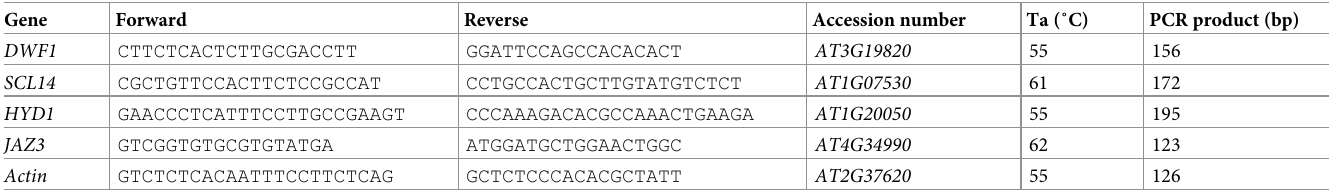
Table 1. Primer sequences used in the study. Gene